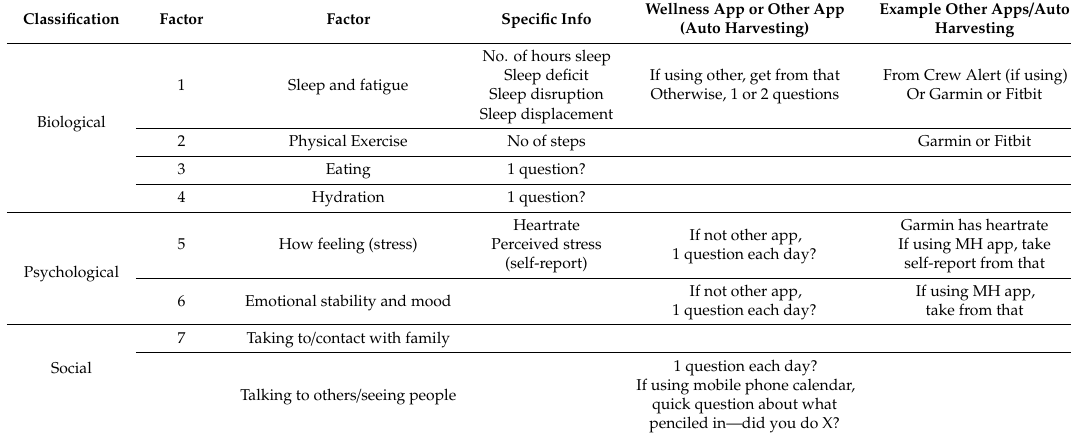
Table A5. Auto harvesting pilot wellness information.